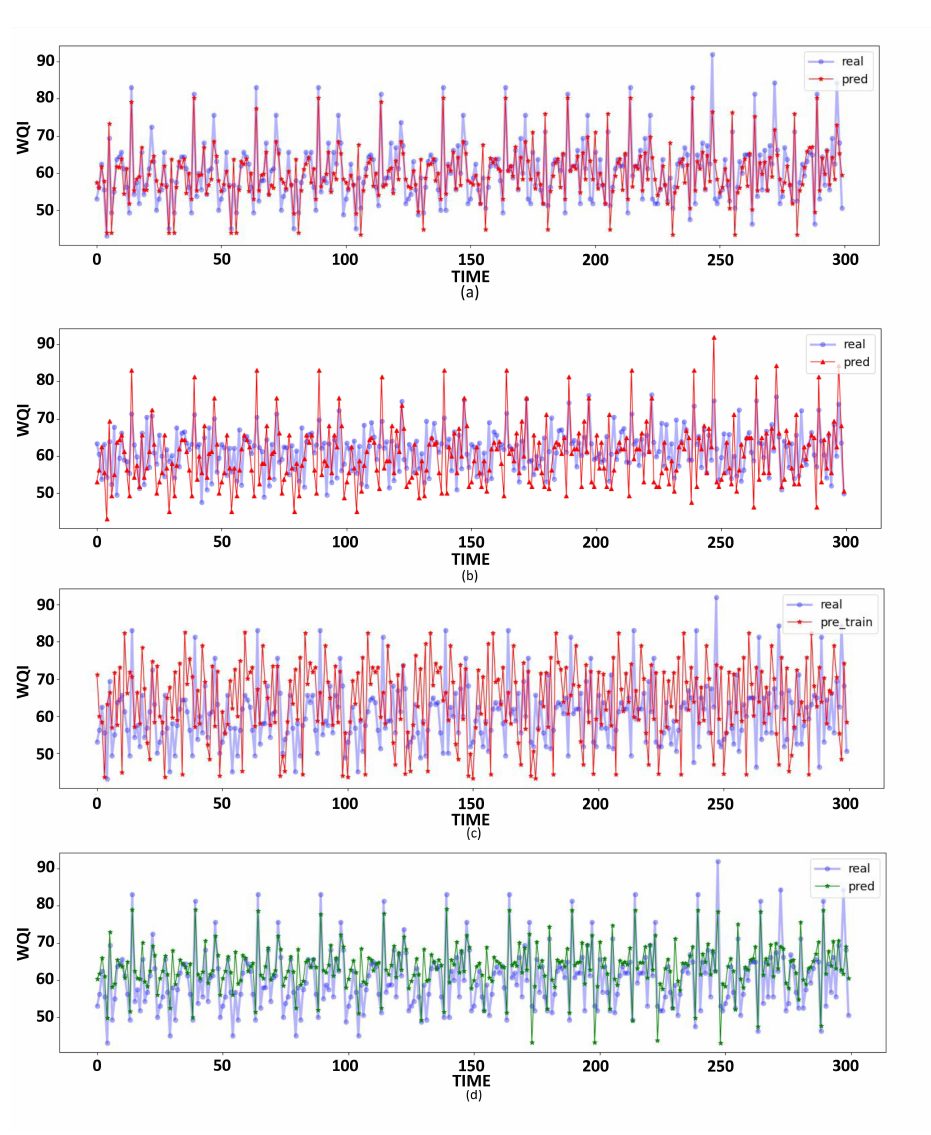
Figure 5. The best performance model for the corresponding algorithm during the test period observes and predicts the temporal variation of the WQI values: ( a ) MLP-S10 ( b ) LSTM-S10 ( c ) RNN- S9 ( d )